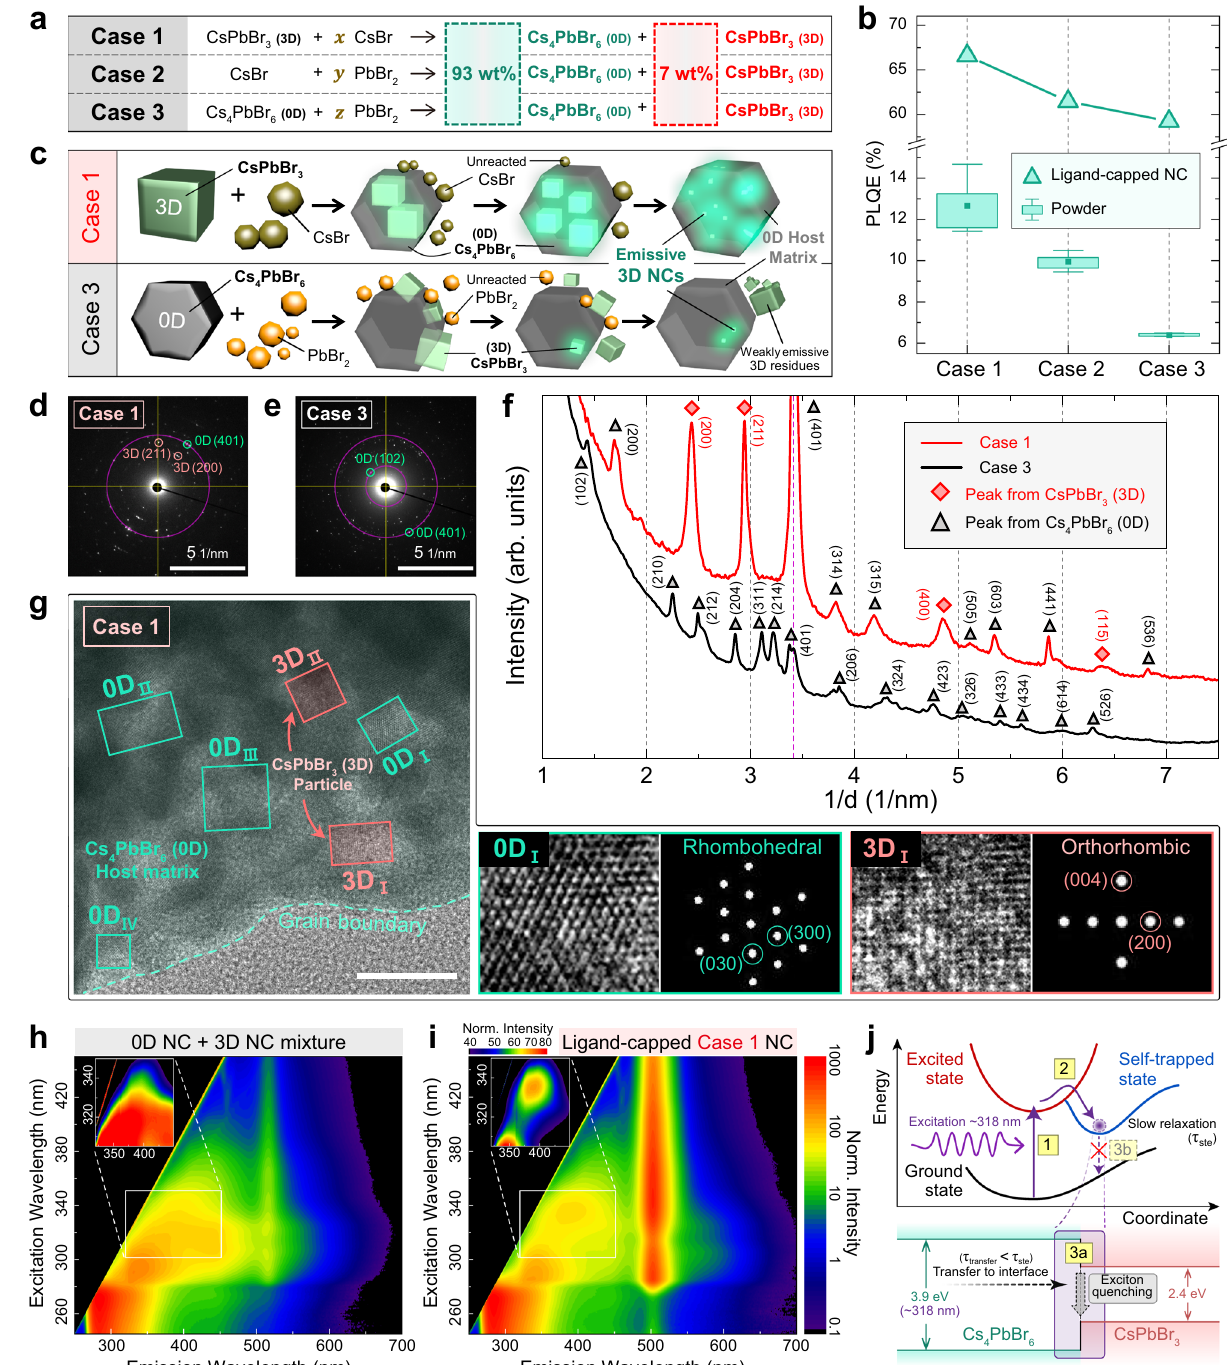
Fig. 5 Target-designed synthesis route for enhancing emissivity of the CsPbBr 3 – Cs 4 PbBr 6 heterostructure. a Three different reaction schemes (Cases 1, 2, and 3) for producing the same fi nal CsPbBr 3 – Cs 4 PbBr 6 stoichiometries but with different initial precursor compositions. b PLQE for Cases 1, 2, and 3 as in powder form (box-and-whisker symbols) and ligand-capped NC form (triangle symbols) under excitation wavelength of 365nm and 405nm, respectively. Samples in powder form were dispersed in toluene for measurements. c Schematic illustration regarding the evolution of heterostructural samples for Cases 1 and 3. Case 1 shows the formation of 0D Cs 4 PbBr 6 from the surface of 3D CsPbBr 3 , whereas Case 3 shows the formation of 3D CsPbBr 3 from the surface of 0D Cs 4 PbBr 6 . d – f SAED patterns of the fi nal products from Case 1 ( d ) and Case 3 ( e ), and graph of the rotational average intensity at a distance ( = 1/ d ) from the center of each pattern ( f ). g HRTEM image of the fi nal product from Case-1 powder. The left image of g is covered with semi-transparent false colors of cyan to indicate the 0D Cs 4 PbBr 6 matrix and magenta to indicate the 3D CsPbBr 3 particles. FFT images (right images in each box of g ) were obtained from the magni fi ed HRTEM images (left images in each box of g ). Scale bar, 20nm. h , i Contour plots of PL intensity as a function of excitation and emission wavelengths from the simple mixture of 0D NC and 3D NC ( h ) and ligand-capped Case-1 NC ( i ). The inset of h and i are rescaled colormaps near the excitation wavelength of 318nm. j Schematic illustration explaining PL quenching in the inset of i at an excitation wavelength with an energy of the bandgap of 0D Cs 4 PbBr 6 (3.9eV; ~318nm). Slow relaxation of self-trapped excitons leads to exciton quenching in the interface of 0D and 3D. Source data are provided as a Source Data fi